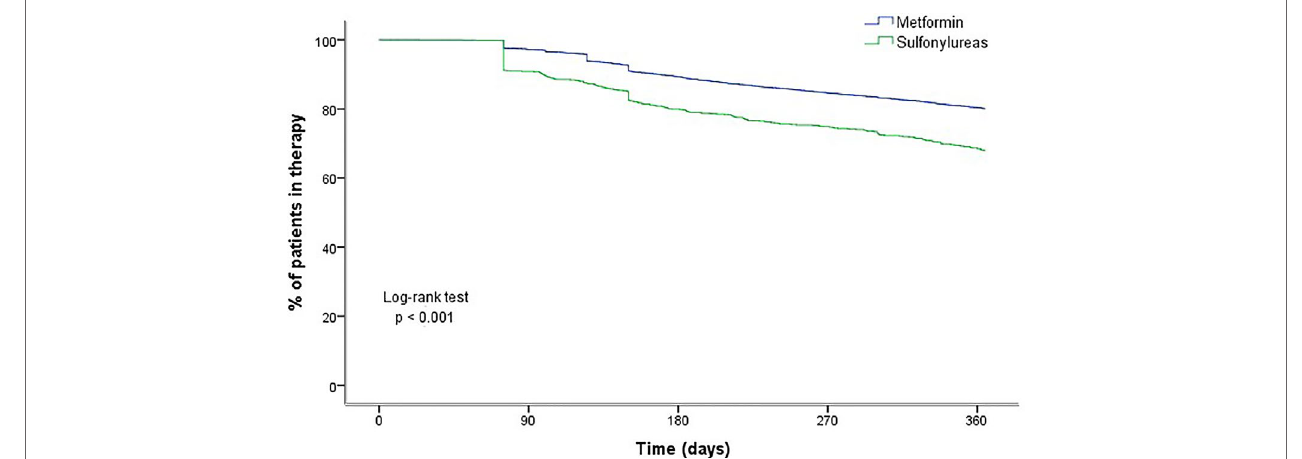
FIGURE 2 | Persistence with antidiabetic drugs at 1 year after initiation, by drug class.